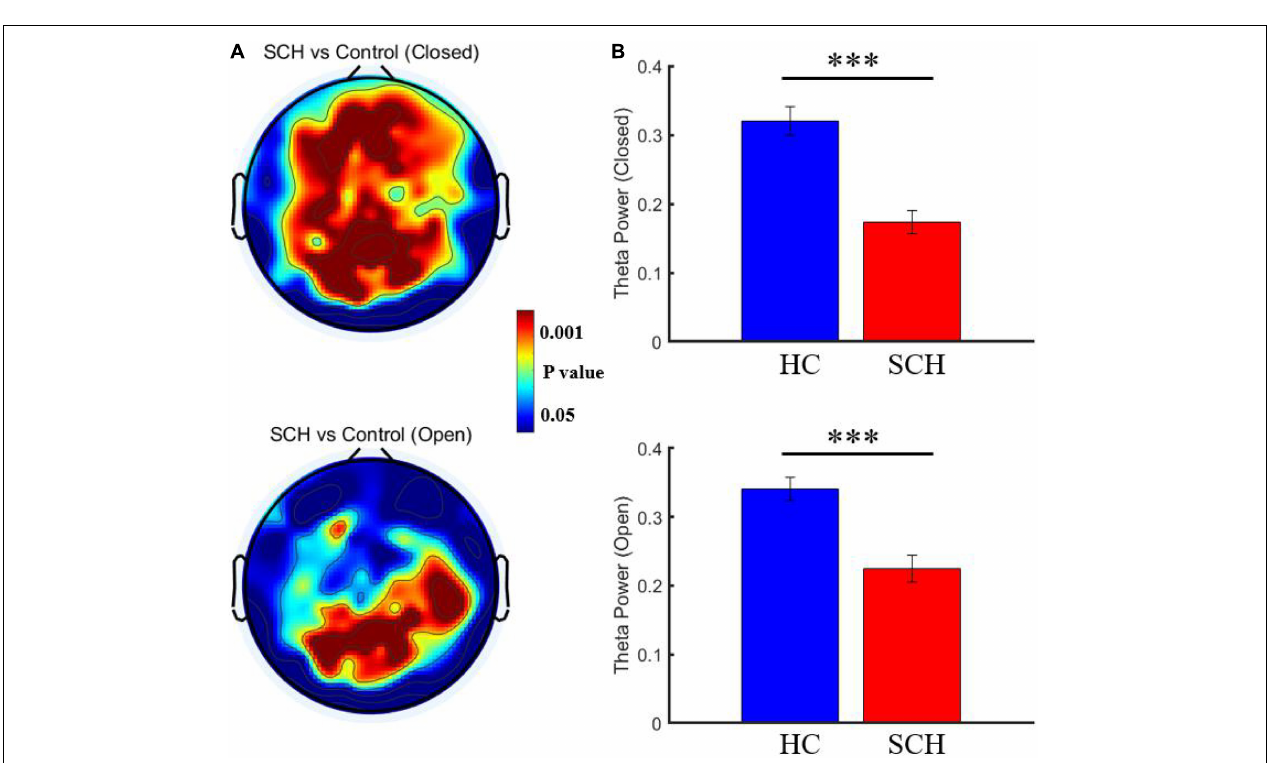
FIGURE 2 | (A) Comparison of resting theta power between schizophrenia and control with eye closed and eye open. (B) Comparison of the mean theta power from channel 72 between schizophrenia and control with eye closed [ P = 1.9073*10 ( − 6 ) ] and eye open [ P = 2.9624*10 ( − 5 ) ]. *** P < 0.0001.